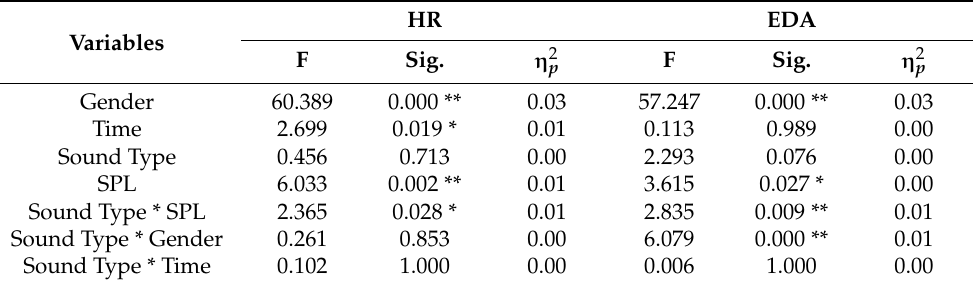
Table 2. MANOVA results of physiological evaluations to traffic sounds. * and ** represent significant difference at 0.05 and 0.01 levels,